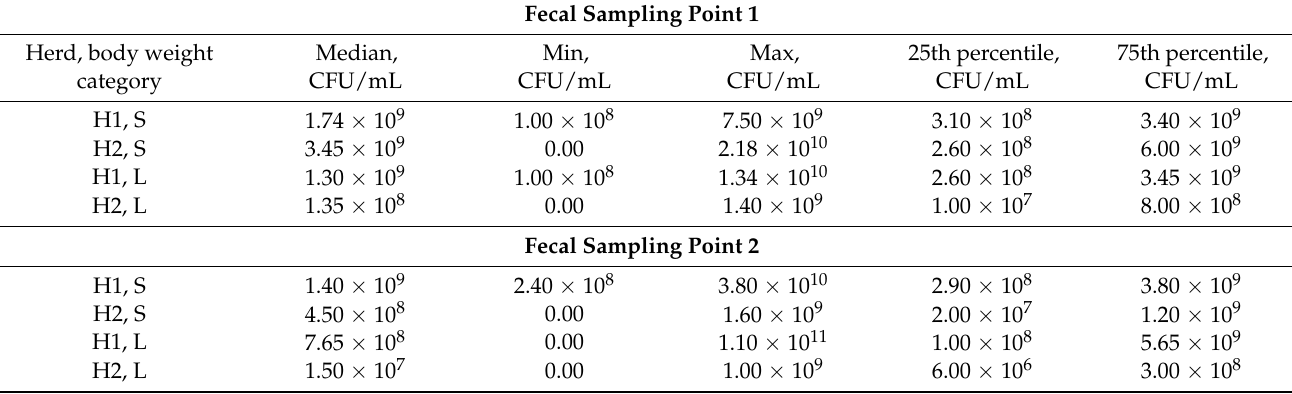
Table 3. Descriptive statistics of total lactobacilli count in 30 study pigs divided by fecal sampling point, herd, and bodyweight category based on their birth weight. H1 = herd 1, H2 = herd 2, S = pigs born small (0.9–1.2 kg), L = pigs born large ( ≥ 1.3 kg). Fecal sampling point 1 occurred when pigs were in the weaning unit and fecal sampling point 2 when pigs were in the finishing